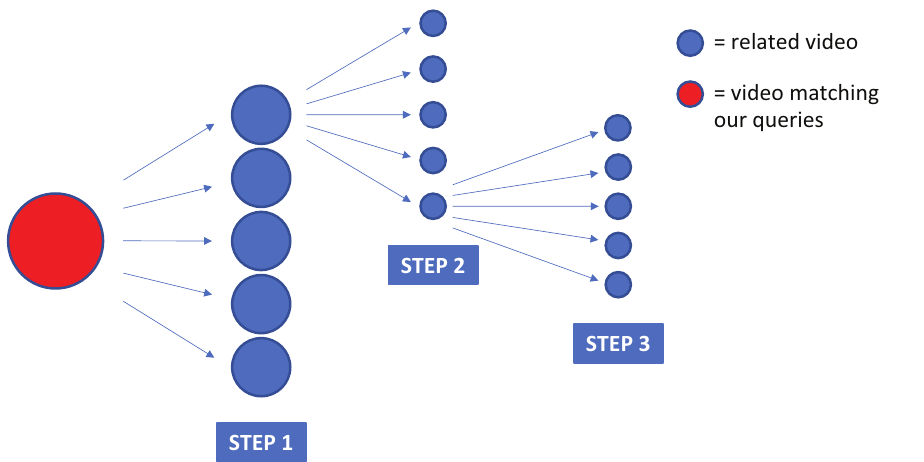
Figure 1. A schematic overview of our scraping